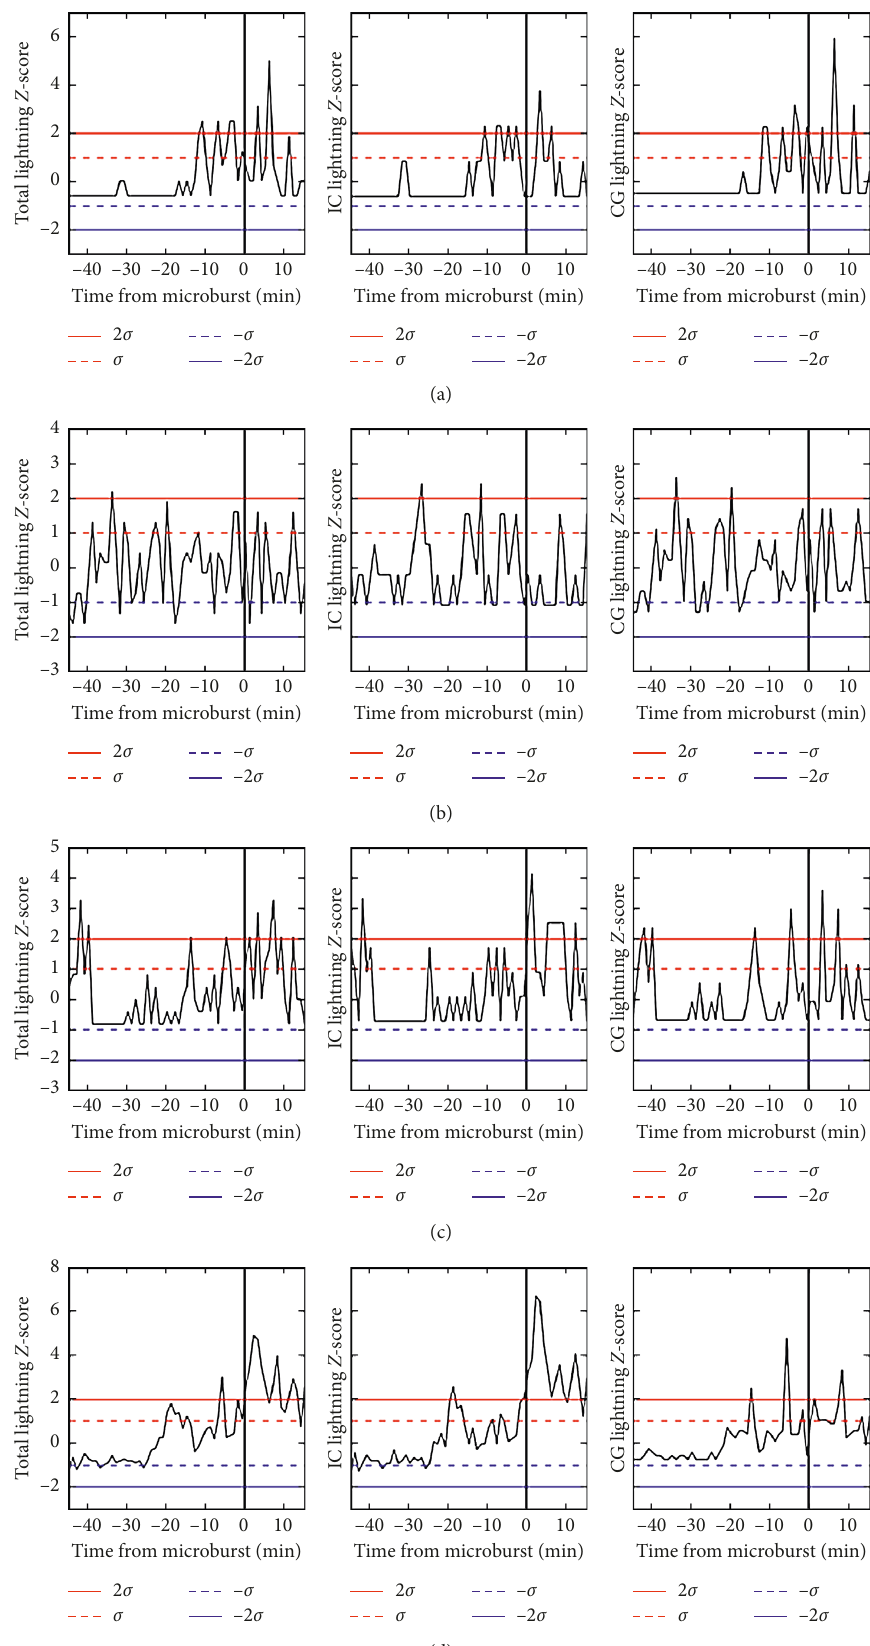
Figure 12: Plots of total lightning, IC lightning, and CG lightning for the first four severe wind cases. (a) 20120724 null. (b) 20130624 null. (c) 20140703 null. (d) 20150612